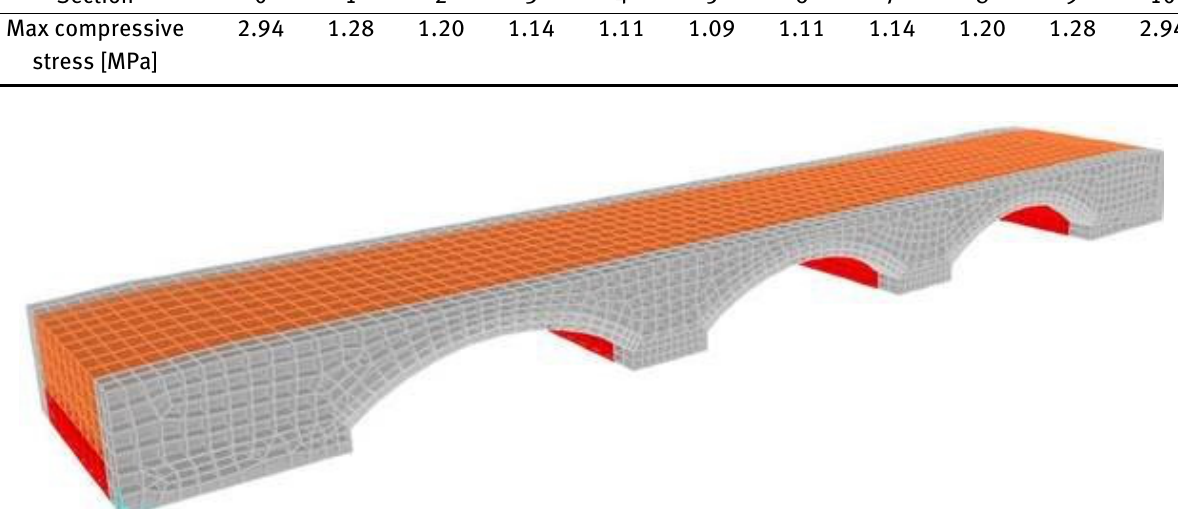
Figure 4: FEM model of Porta Napoli bridge